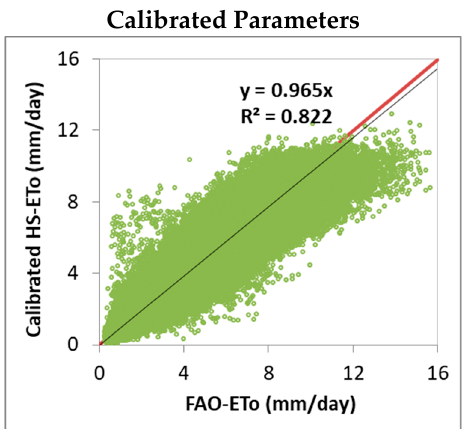
Table 1. Original and calibrated coefficient values of the selected empirical equations.